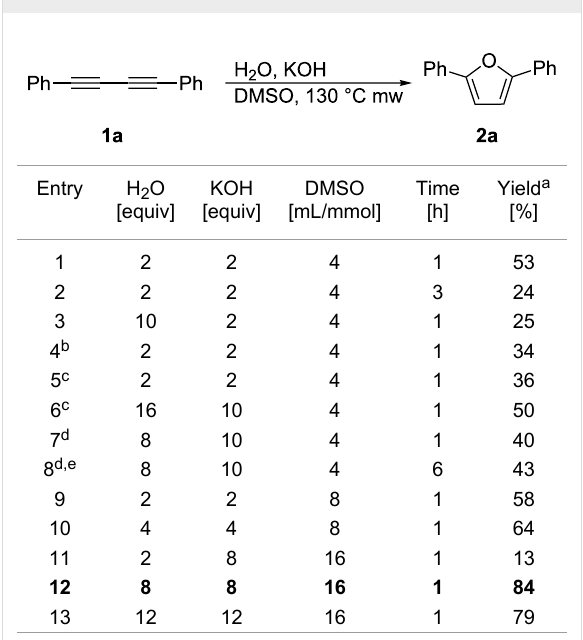
Table 1: Evaluation of different reaction